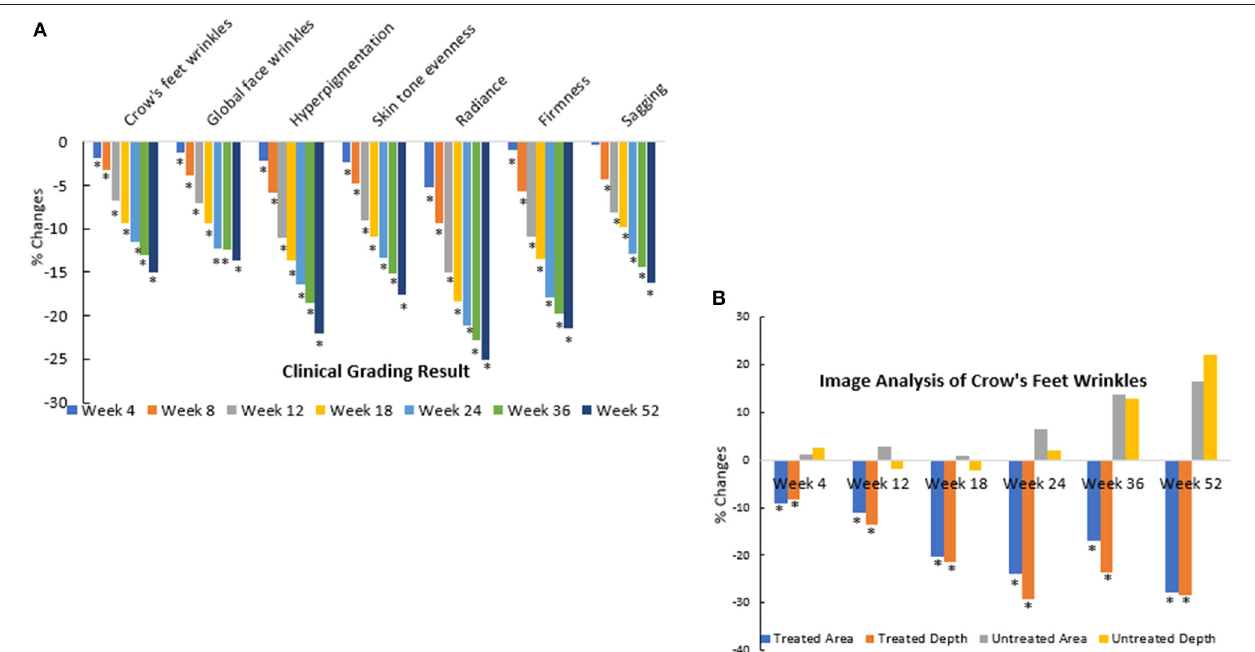
FIGURE 12 | Clinical trial #2 results. (A) Dermatological evaluation of 1-year clinical efficacy results. Clinical grading results show reduction (improvement) in photoaging parameters at different timepoints over a 1-year period when compared to baseline scores (* p < 0.05). Statistical significance was achieved for most parameters at week 4 and for all parameters starting from week 8. Note that the improvement was gradual and continuous over the course of the year. (B) Image analysis of 1-year clinical efficacy results on crow’s feet wrinkles. Image analysis shows reduction (improvement) in wrinkle parameters at the crow’s feet area at different timepoints over a 1-year period when compared to baseline values (* p < 0.05). Note that the untreated side showed worsening over time.